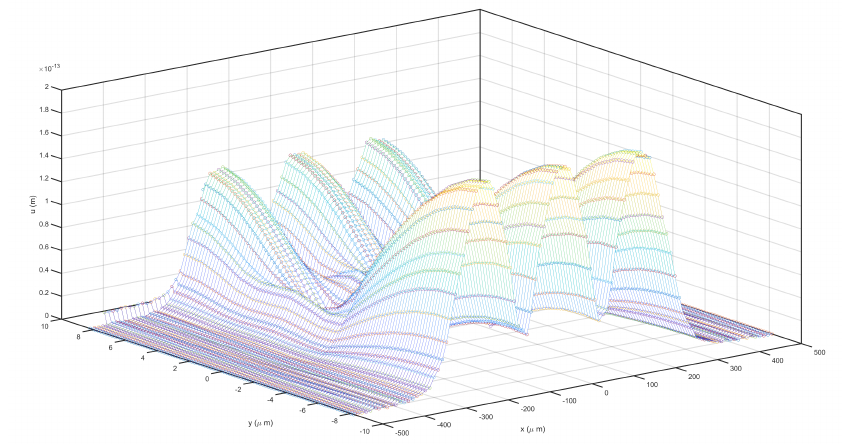
Figure 14. Horizontal displacement of mode 3.